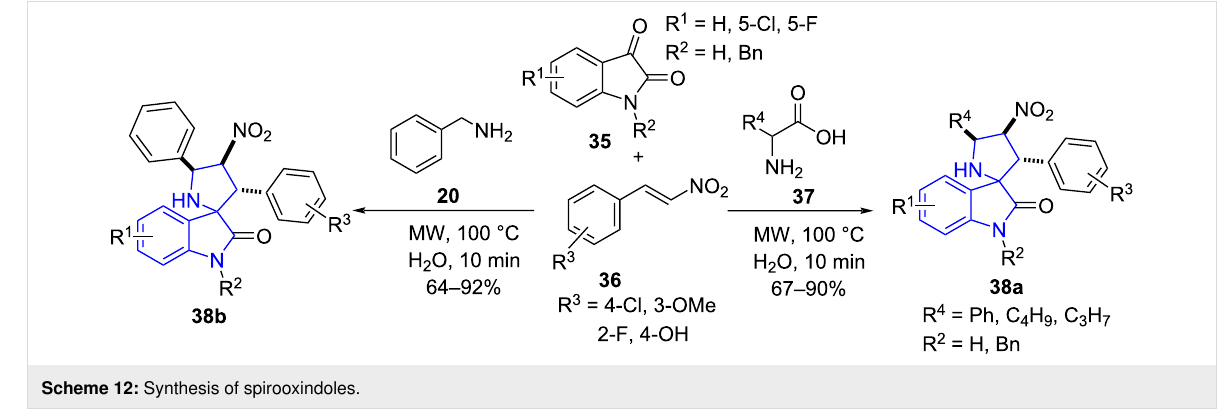
Scheme 12: Synthesis of spirooxindoles.